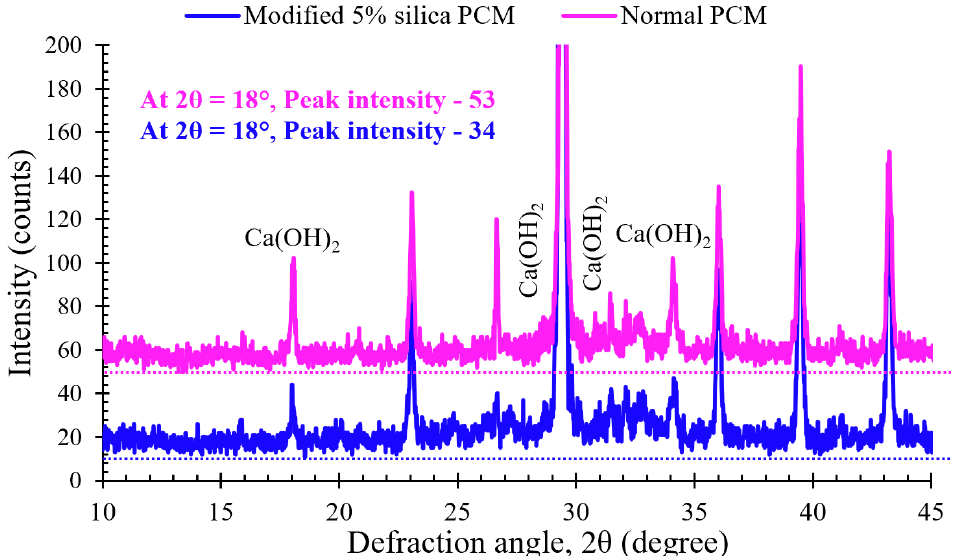
Figure 6. XRD pattern of the sample collected from the interface of the composite specimen.